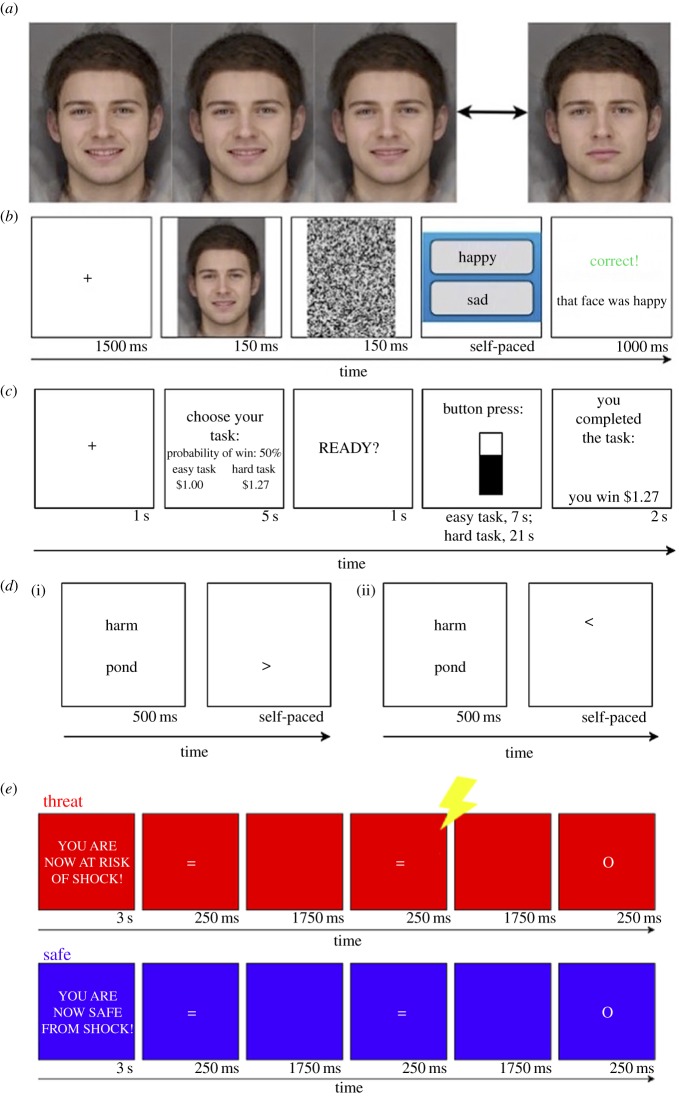
Task schematics. (a) Bias modification happy face morph (faces 3–5 on 15 face positive-neutral to negative-neutral spectrum) and a sad face (face 12). (b) Example bias modification trial with feedback (correct/incorrect window; in the training phase only). Baseline and test phases follow the identical structure but do not provide feedback. (c) Example of a successful hard task selection in EEfRT task. (d) Two words differing in emotional valence (threat/neutral) were presented simultaneously (500 ms), followed by a probe (> or <) that replaced either I. the neutral word or II. the threat word. (e) Participants pressed the space bar as quickly as possible in response to frequent ‘go’ stimuli (‘ = ’) and inhibited their response to infrequent ‘no-go’ stimuli (O).